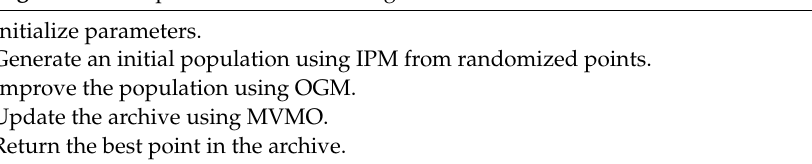
Algorithm 1 Proposed IPOG-MVMO